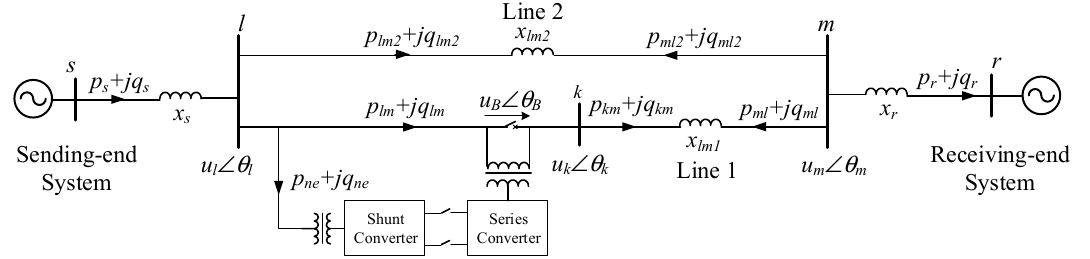
Figure 3. Schematic diagram of the UPFC-embedded line and the external system.